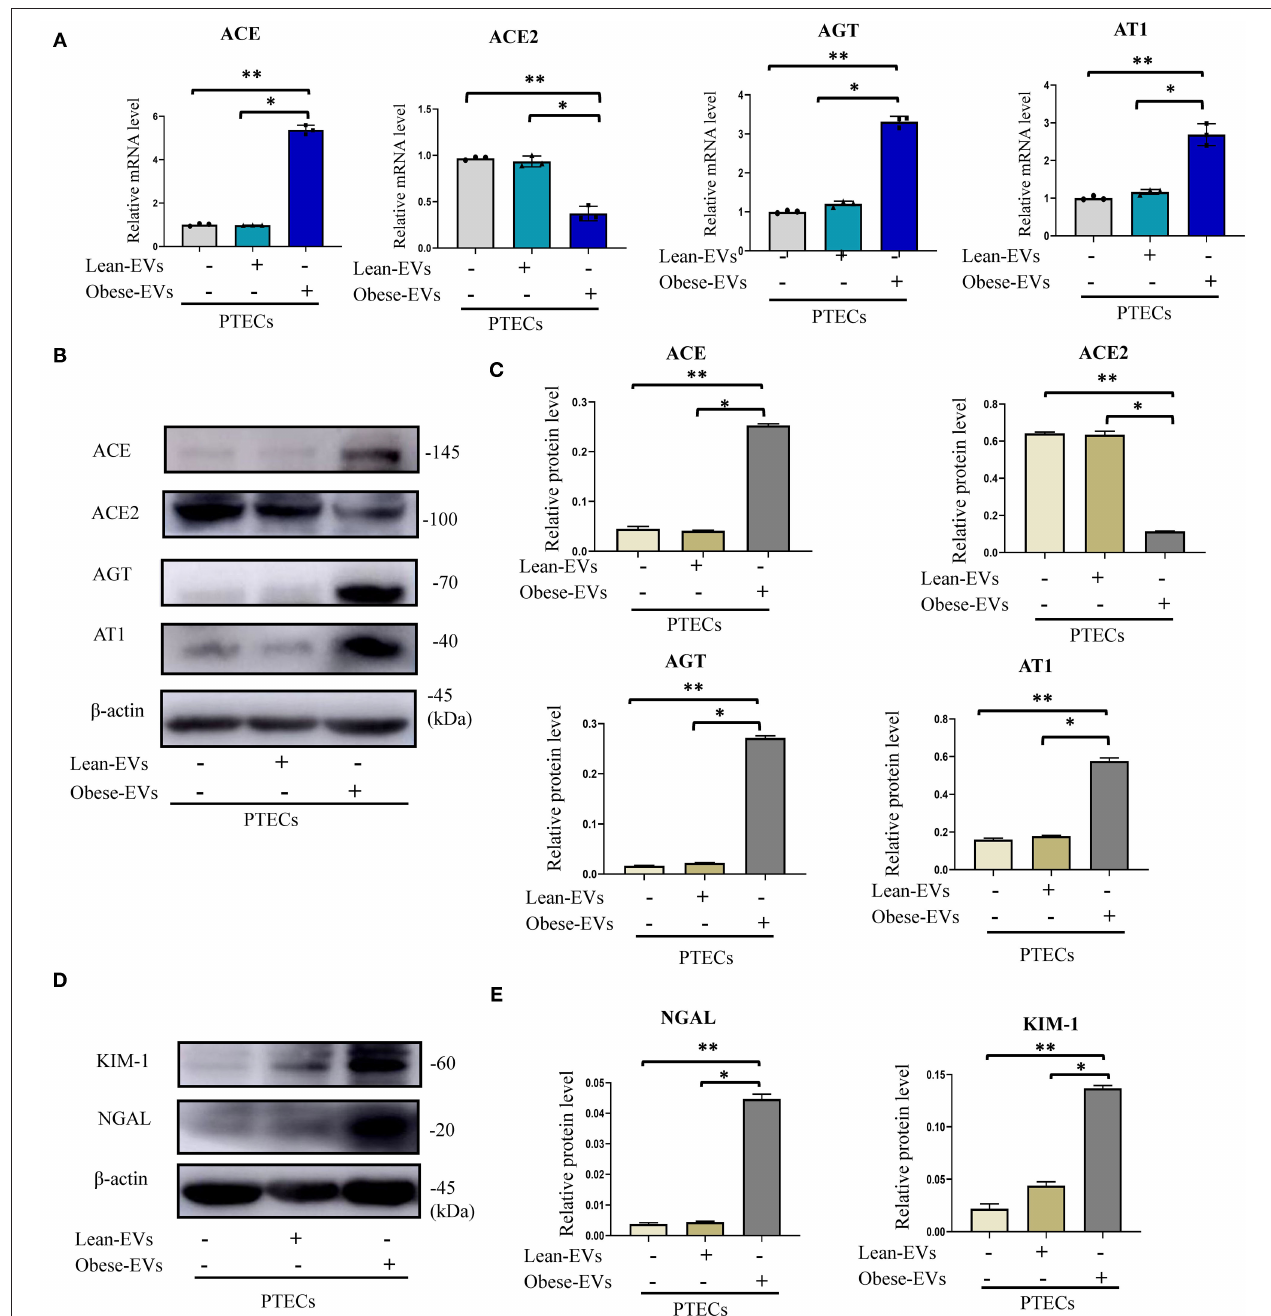
FIGURE 3 | Effects of plasma EVs on renal tubule injury and RAS activation in obesity. (A–C) After treating PTECs with PBS(negative control), Lean-EVs, or Obese-EVs, the relative mRNA and protein levels of AGT, ACE, ACE2, and AT1 were analyzed by qRT-PCR (A) and Western blotting (B,C) ( n = 3 per group). (D,E) Levels of KIM1 and NGAL protein in PTECs treated with PBS, Lean-EVs, or Obese-EVs. Data are presented as mean ± SD; ** P < 0.001 vs. PBS, * P < 0.001 vs. Lean-EVs. EVs, extracellular vesicles; PTECs, Proximal tubular epithelial cells; KIM-1, kidney injury molecule-1; NGAL, neutrophil gelatinase-associated lipocalin; AGT, angiotensinogen; ACE, angiotensin-converting enzyme; ACE2, angiotensin-converting enzyme 2; AT1, angiotensin 1.